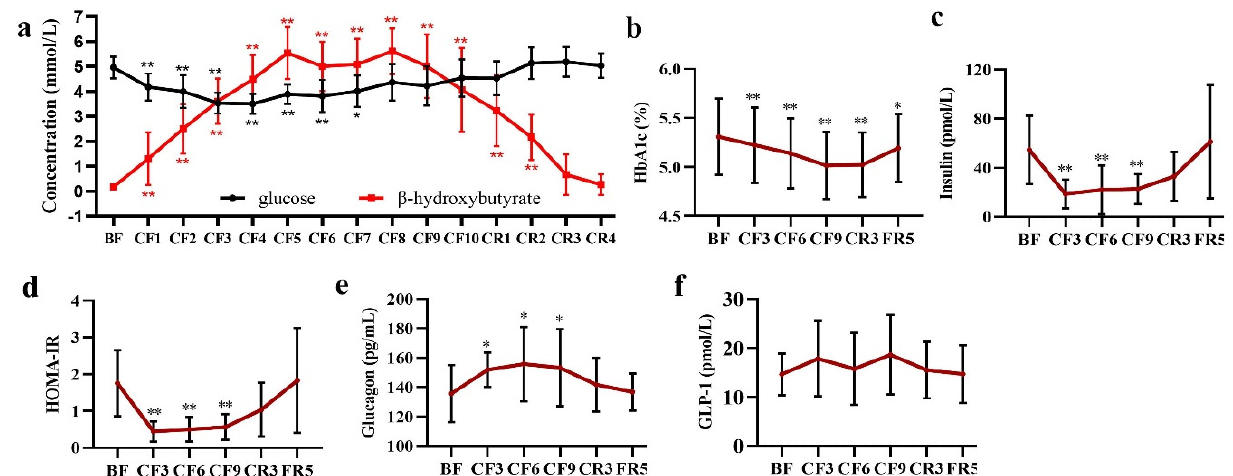
Figure 5. The alteration of glucose ( a , b ) and glycoregulators ( c – f ) during 10-day CF and refeeding period. * p < 0.05, ** p < 0.01 vs. BF; n = 13. BF: before fasting, CF: complete fasting, CR: calorie restriction, FR: full recovery; the number depicts days. HbA1c: Hemoglobin A1c, HOMA-IR: Homeostatic Model Assessment of Insulin Resistance; GLP ‐ 1: glucagon ‐ like peptide ‐ 1.